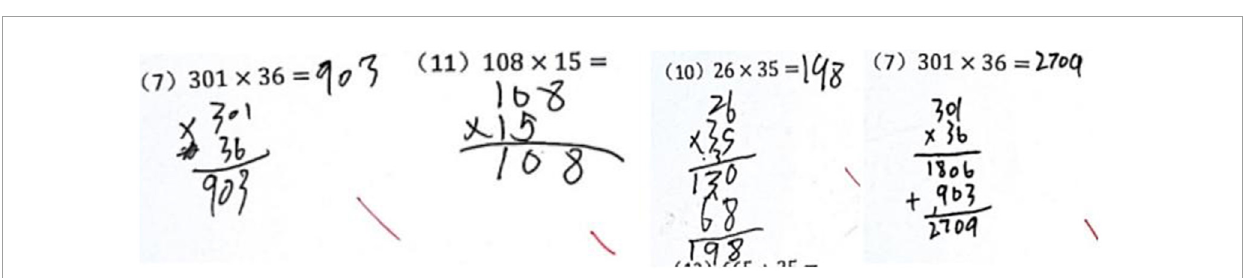
FIGURE5 High alignment and start-from-high-bit arithmetic error, recede-to-the-right error.